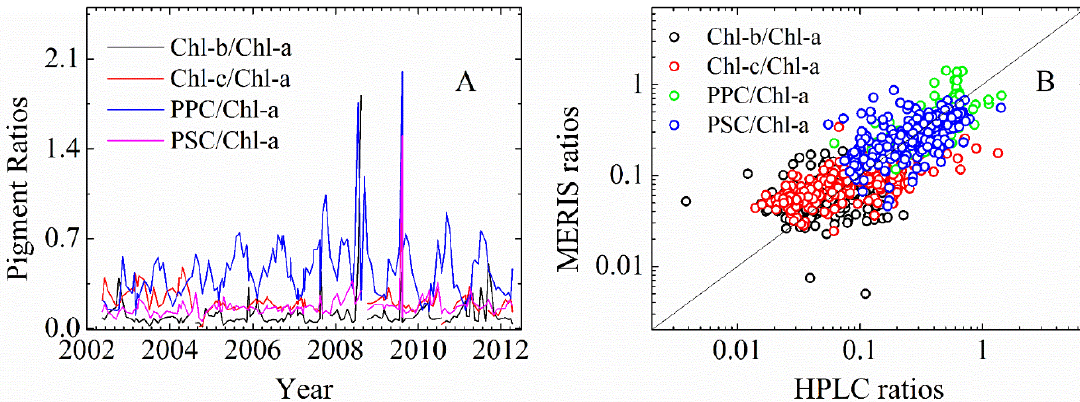
Figure 6. A : Time series of phytoplankton pigment to chlorophyll a (Chl-a) ratios at BATS from HPLC measurements. B : Chl-b, Chl-c, PPC and PSC to Chl-a ratios from HPLC versus from MERIS measured R rs ( λ ) using MuPI.